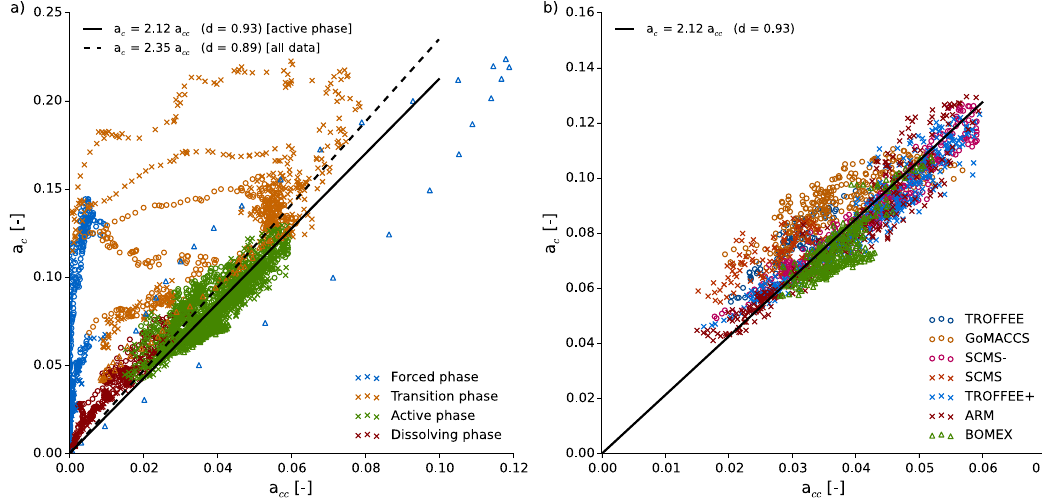
Figure 2. Scaling of the area fraction of clouds as a function of the area fraction of cloud cores. In panel (a) all data are presented, where a distinction is made between different phases of convection during the day. The lines represent the best fit through the active phase and all data, forced through 0. In panel (b) the selected data are shown for each ShCu case. Circles indicate free convection situations, while crosses indicate wind situations. To differentiate BOMEX from the other cases, BOMEX is marked with triangles in panels (a) and (b) . Furthermore, d represents the index of